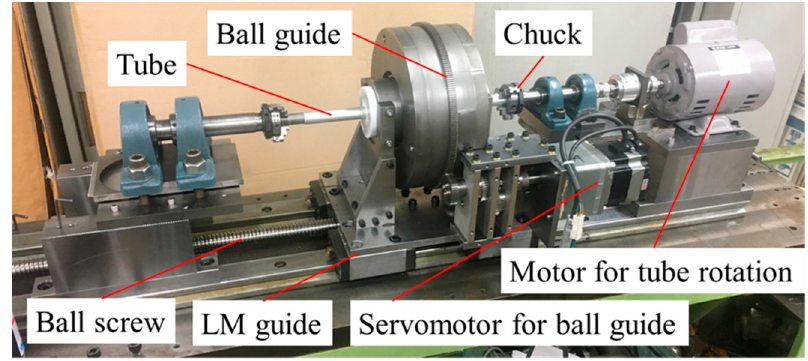
Figure 10. Overall view of the experimental equipment.